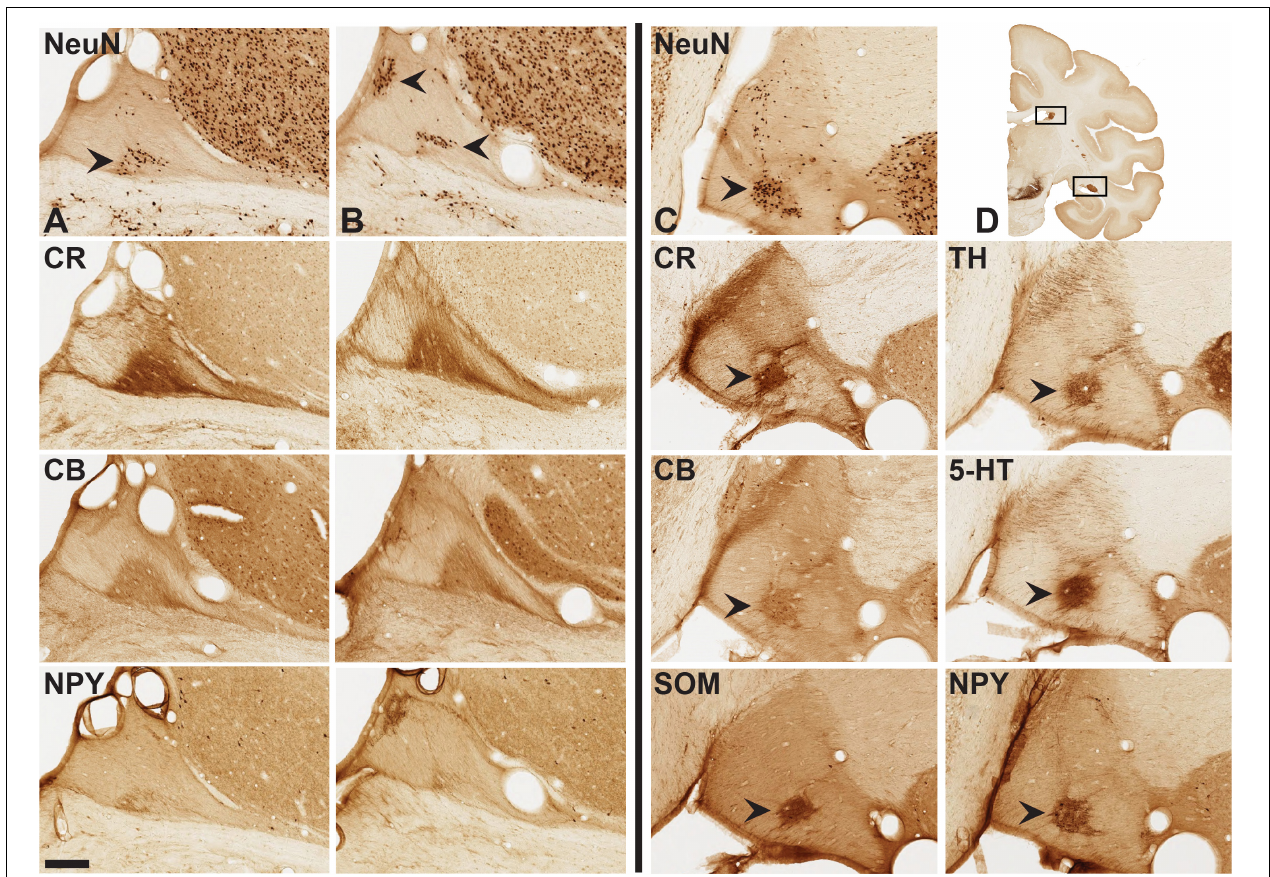
FIGURE 4 | Aggregates of neurons [arrowheads in (A–C) : NeuN] and mixed neurons/neuropil (CR, CB, NPY). Panels (A,B) are two closely adjoining AP levels of dST, with three further sections in the subjacent rows. Sections at left of vertical line are from adult brain 72, and those at right of the vertical line are from adult brain 79. Arrowheads in brain 79 (at right) indicate cell, and/or neuropil aggregates in closely adjoining sections for CR, CB, SOM, TH, 5-HT, and NPY. Coronal section inset (D) indicates general location of dST and vST (hollow boxes). Medial is to the left. Scale bar = 200 µ